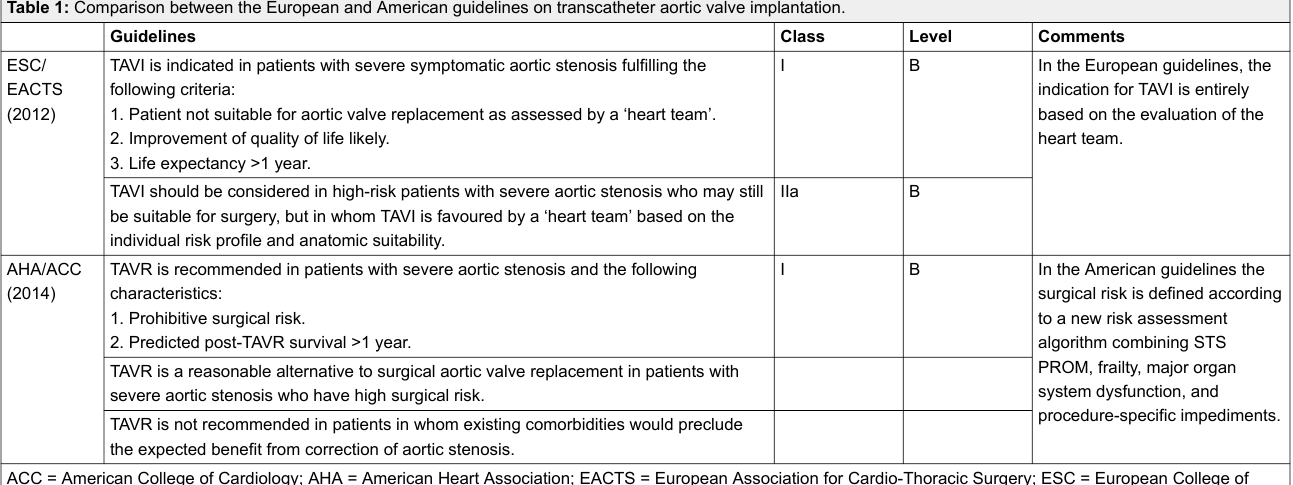
Table 1: Comparison between the European and American guidelines on transcatheter aortic valve